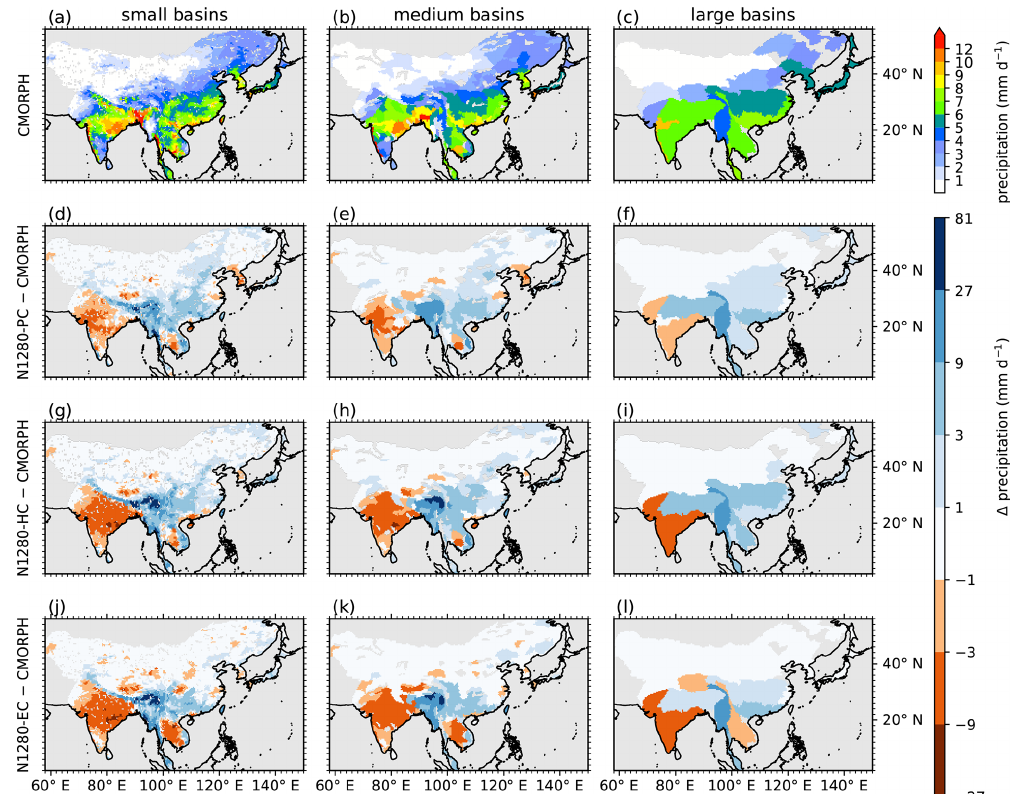
Figure 4. Mean JJA precipitation over Asia averaged over basins of different scales showing CMORPH (a–c) and difference between simulations and CMORPH for N1280-PC (d–f) , N1280-HC (g–i) and N1280-EC (j–l) . One basin scale is shown in each column, and one dataset is shown in each row. Areas shown in grey are not covered by selected basins (see Sect. 2.4.1 and